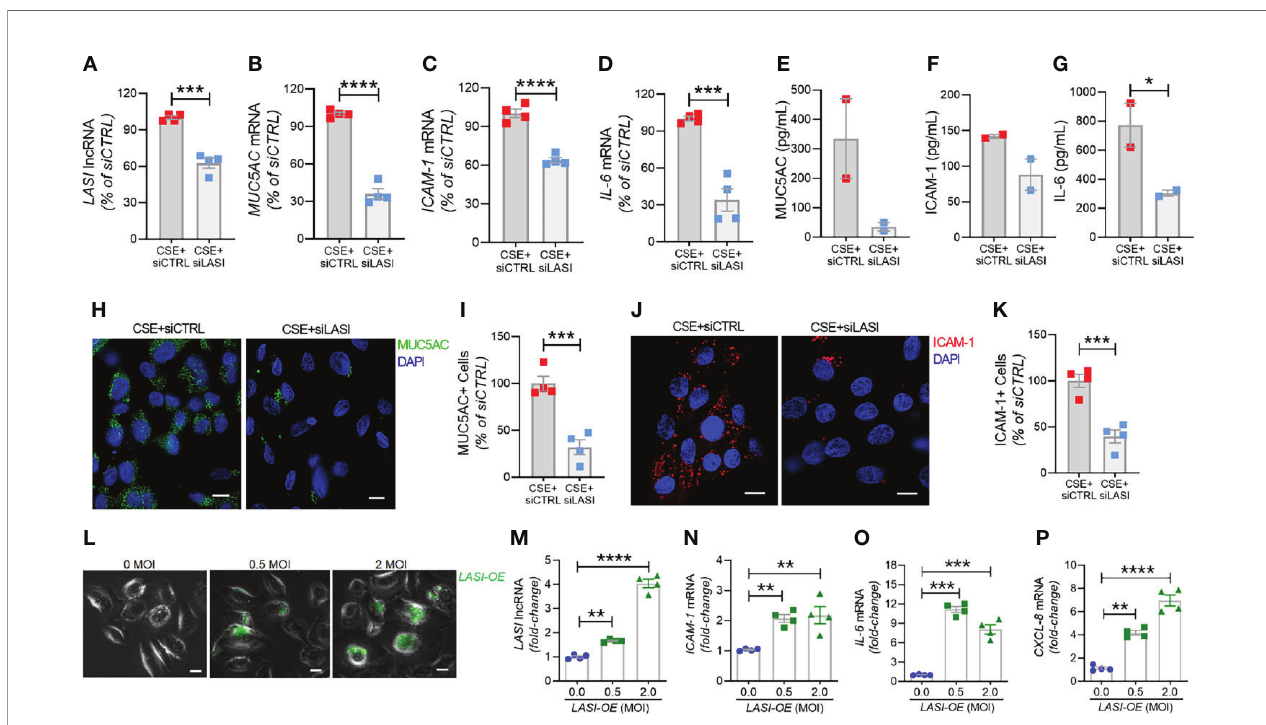
FIGURE 6 | Silencing LASI lncRNA suppresses the CSE-induced mucoin fl ammatory responses whereas LASI overexpression augments the expression of in fl ammatory factors. CHBEs grown in 3D ALI tissue culture conditions were transfected with either siRNA targeting LASI (siLASI) or scrambled control siRNA (siCTRL), and cells were treated with 20 µg/ml CSE to obtain CSE+siLASI and CSE+siCTRL cells, respectively. Cells harvested forty-eight hours post CSE-treatment were analyzed for the expression levels of LASI lncRNA (A) , and mRNA levels of MUC5AC (B) , ICAM-1 (C) , and IL-6 (D) by qRT-PCR. Apical washes from 3D tissue cultures were analyzed for MUC5AC mucin (E) by ELISA, and the basal media supernatants were analyzed for ICAM-1 (F) , and IL-6 (G) protein levels by speci fi c ELISA assays. (H) Representative micrographs of CHBEs transfected with siCTRL or siLASI and treated with CSE showing MUC5AC mucin immunopositivity (shown in green) and nuclei were stained by DAPI (shown in blue), scale – 5µm. (I) Quanti fi cation of MUC5AC+ cells among CSE+siLASI CHBEs, shown as percentage of CSE+siCTRL cells. (J) Micrographs of CHBEs showing ICAM-1 immunopositivity (shown in red), scale – 5 µm. (K) Quanti fi cation of ICAM-1+ CHBEs. Data shown as mean ± SEM compared to CSE+siCTRL cells (n=4); data analyzed by student ’ s t-test; * p <0.05; *** p <0.001; **** p <0.0001. (L) Representative micrographs of cells transduced with 0, 0.5, and 2 MOI of LASI-OE lentiviral preparation showing GFP reporter fl uorescence (shown in green) and phase contrast images of cells, scale – 5µm. Cells harvested forty-eight hours post-transduction were analyzed for expression levels of LASI lncRNA (M) , and mRNA levels of ICAM-1 (N) , IL-6 (O) , and CXCL-8 (P) by qRT-PCR. Data shown as mean ± SEM compared to mock-transduced cells (0 MOI); data analyzed by ANOVA with multiple comparisons; ** p <0.01; *** p <0.001; **** p